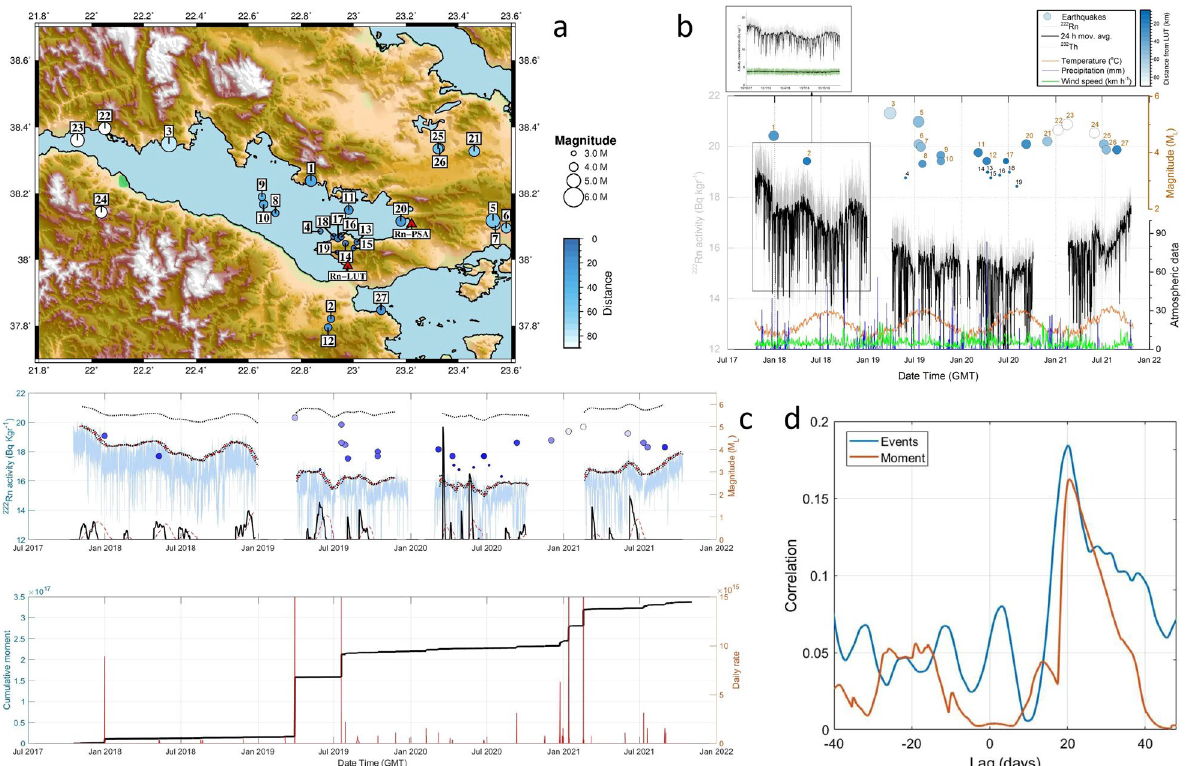
Figure 4. ( a ) Seismic events selected under the Dobrovolski criterion. ( b ) Radon soil concentration measurements of Loutraki (LUT) station. The general trend resembles the stress variations of the region. The abrupt drops correspond to strong earthquakes. The radon measurements are not affected by the temperature variation. The stability of thorium measurements (embedded picture) is an indirect indicator of the validity of the full spectrum analysis applied on the radon measurements. ( c ) Top panel: the identification of the radon anomalies was based on an STA/LTA algorithm applied to the envelope of the radon measurement time series. The points where after a systematic built-up of a radon increase, a rapid drop of radon level is observed, are detected by the negative values of the first derivative (red line) of the STA/LTA values. The second derivative (black line) of these indicates exactly the initiation time of the drop anomalies. Bottom panel: the cumulative seismic moment and daily rate are shown with black and red lines respectively ( d ) The result of the cross- correlation between the second derivative of radon anomalies and the times of selected events (blue line) as well as the peaks of the daily seismic moment